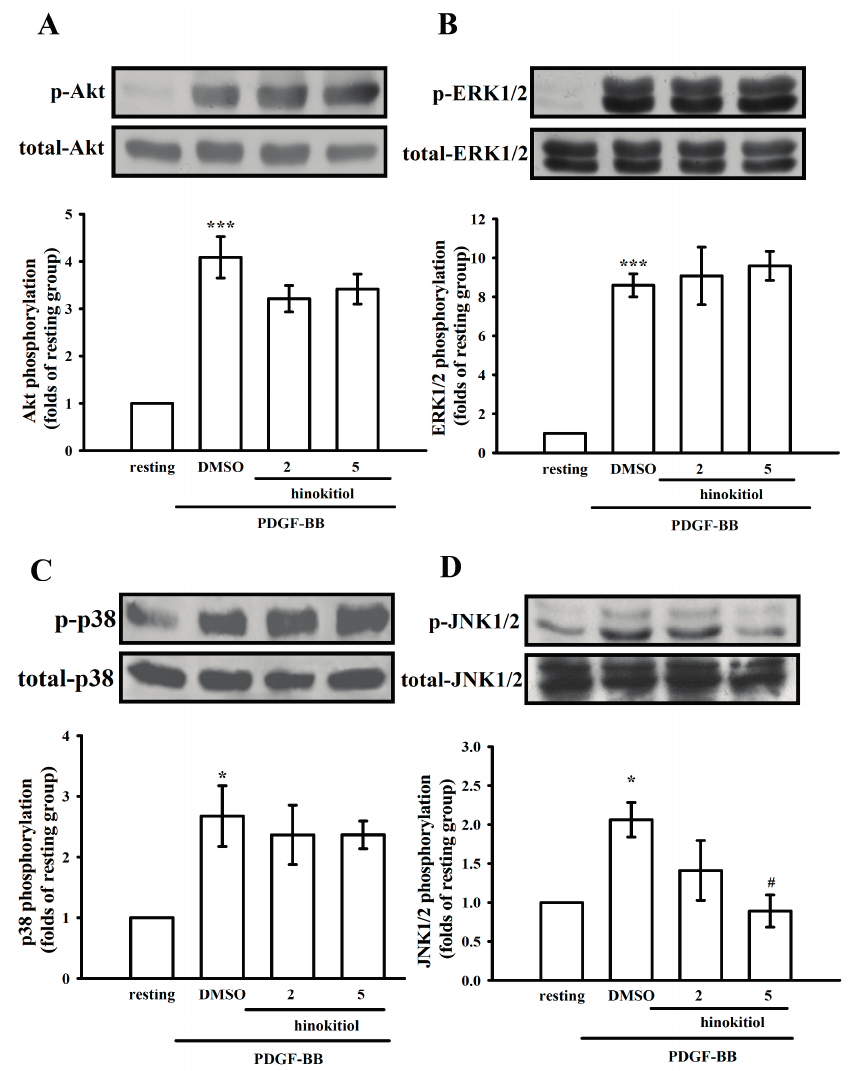
Figure 4. Effect of hinokitiol on PDGF-BB signaling pathway in VSMCs. Confluent cells were pre-treated in the presence or absence of hiokitiol (2–5 μ M) in a serum-free medium, and then stimulated with 10 ng/mL PDGF-BB at 37 °C for 10 min. The cells were lysed, and the levels of ( A ) p-Akt; ( B ) p-ERK1/2; ( C ) p-p38 and ( D ) p-JNK were analyzed by SDS-PAGE and immunoblotting. The respective total proteins were used for the normalization of phosphorylated ones. Data are expressed as a mean ± S.E.M. (A–C, n = 3; D, n = 4) * p < 0.05, *** p < 0.001 compared to the normal cells, # p < 0.05 compared to the PDGF-BB stimulated